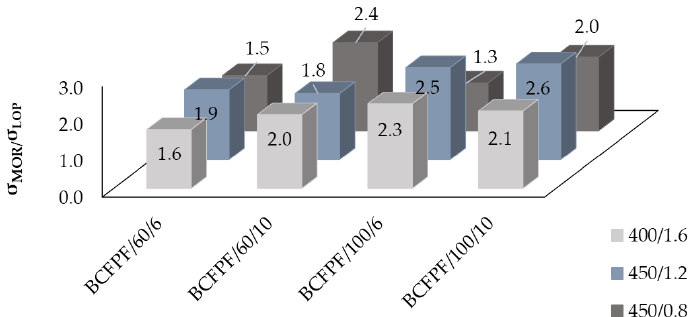
Figure 14. Graphs of the σ MOR /σ LOP ratio for BCFPF (bundles of coiled fibrillated-tapes polypropylene fibers) depending on the length and amount of fibers.